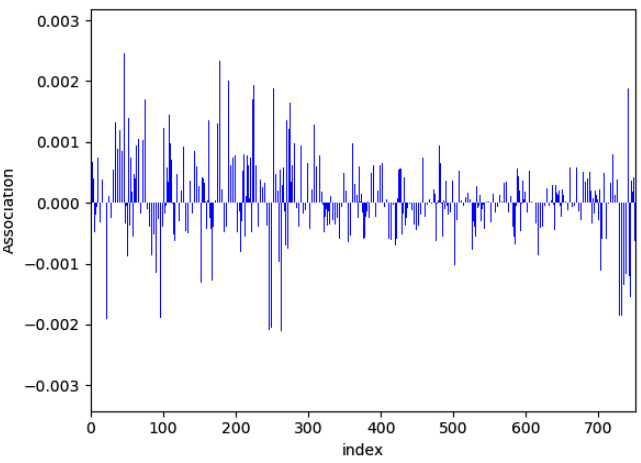
Figure 10. Learning parameter β .